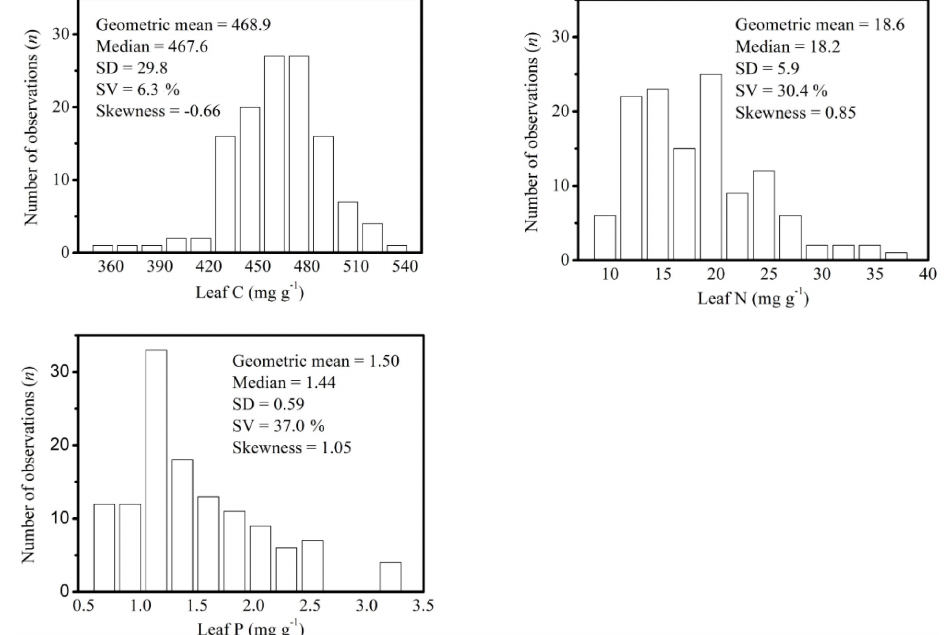
Figure B4. Distribution of leaf C, N and P concentrations of all shrubs on the Tibetan